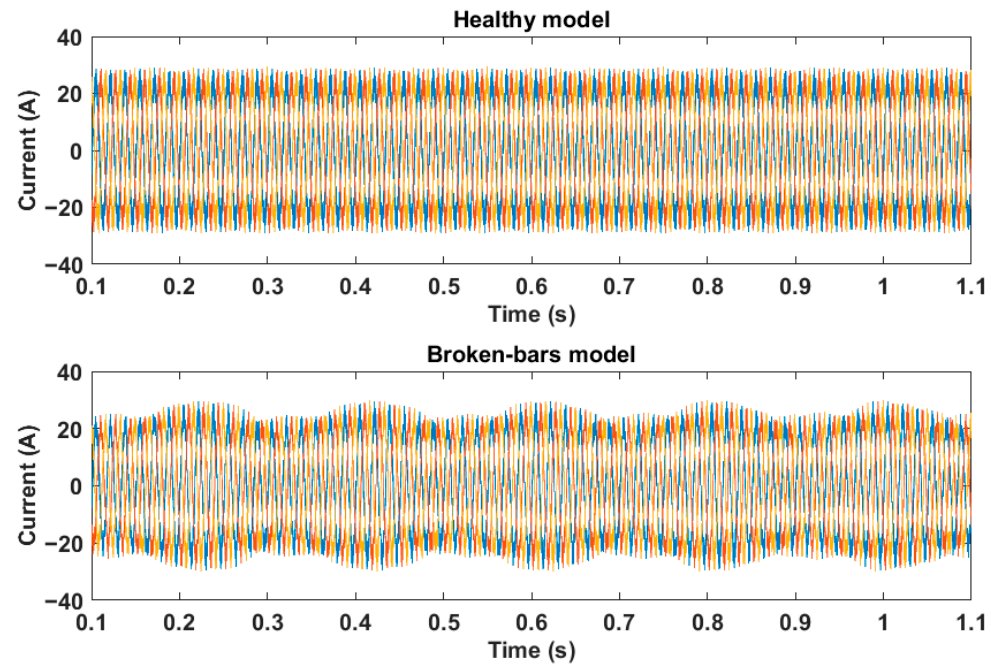
Figure 3. Currents of the models with and without fault in the time domain.